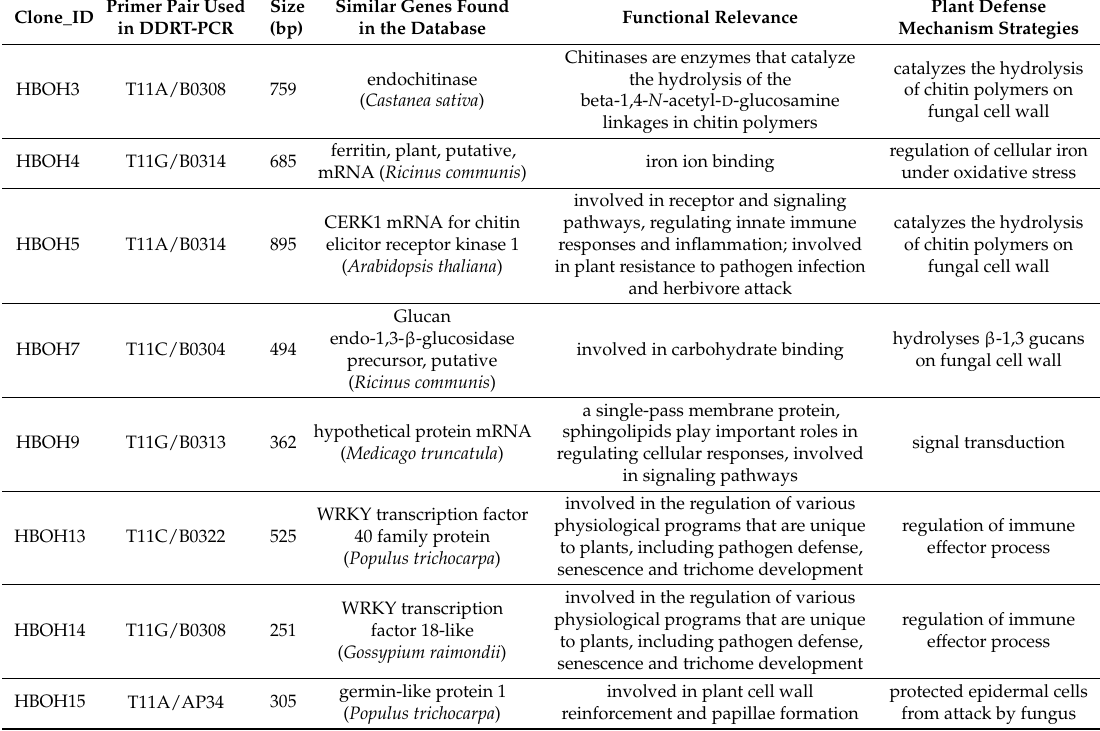
Table 2. Sequence homology of differential display-PCR clones to sequences in the GenBank